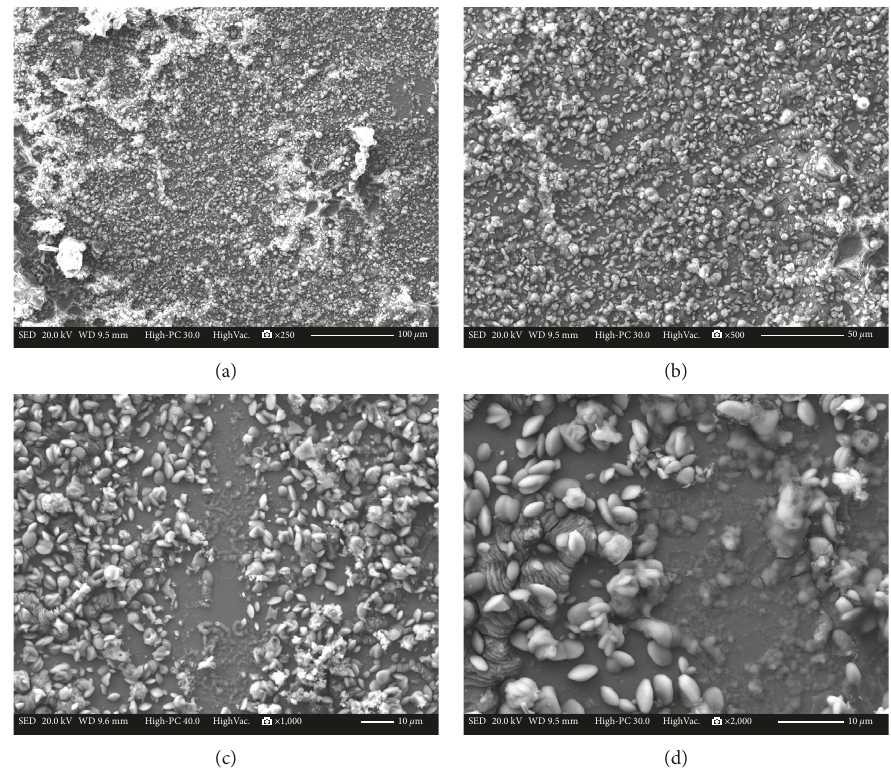
Figure 11: Surface appearance of the API X70 steel after 100 hours of immersion in 3.5% NaCl solution with the addition of 0.001M Nd 3+